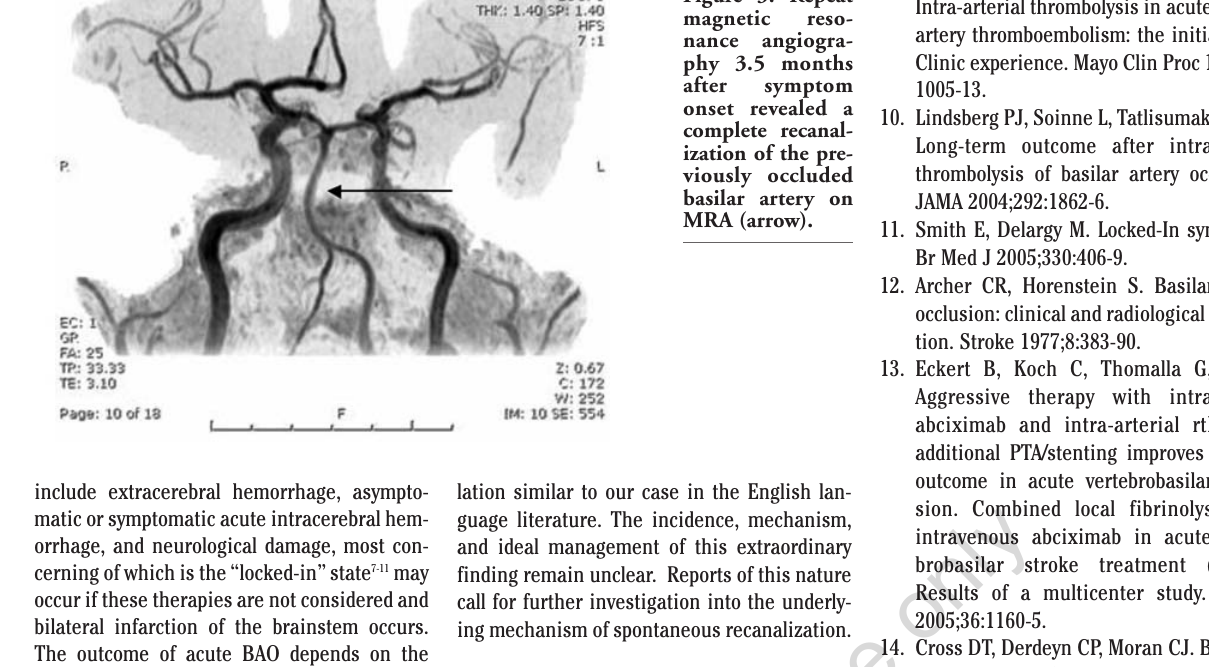
Figure 3. Repeat magnetic reso- nance angiogra- phy 3.5 months after symptom onset revealed a complete recanal- ization of the pre- viously occluded basilar artery on MRA